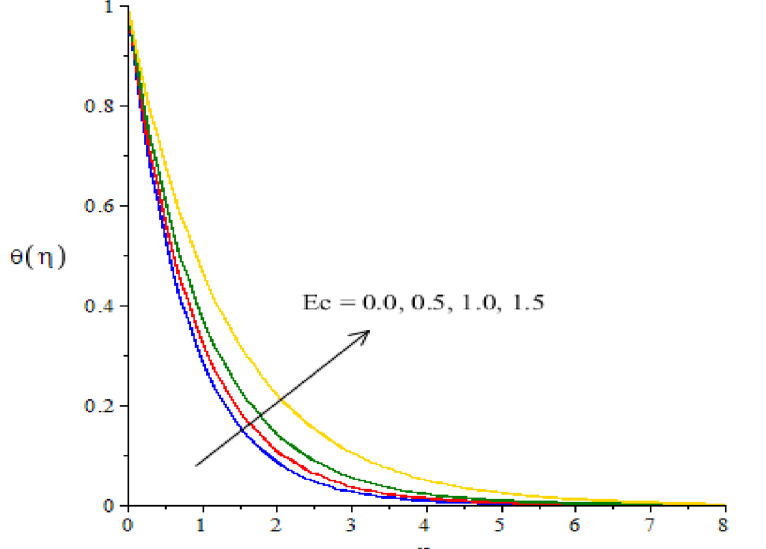
Figure 11. The graphical view of temperature versus Ec